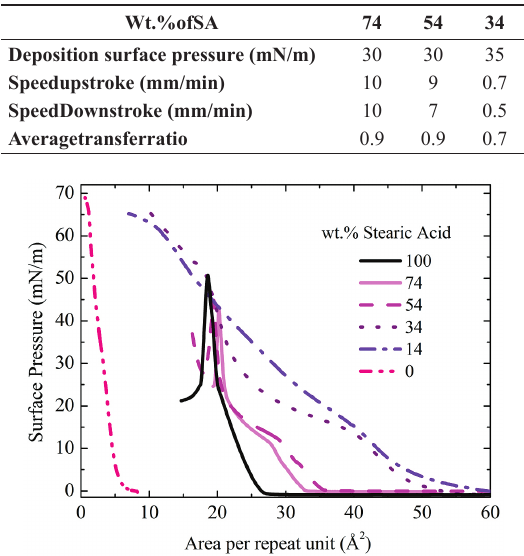
Figure 1. Structure of a) P3OT and b) SA molecule repeat unit. Figure 2. Surface pressure vs. area of P3OT/SA LB